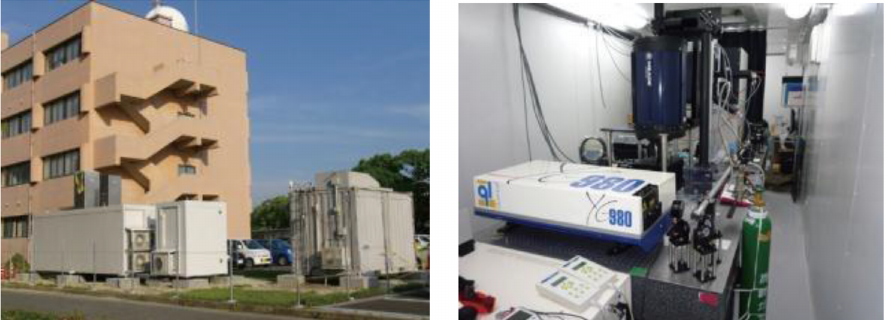
Figure 1. The Mie lidar and ozone DIAL (right picture) were installed in the container at the left on the ground (left